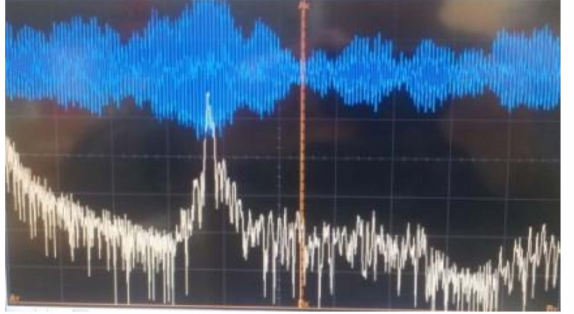
Figure 13. Signal detail after an o/e conversion and its spectrum—coherent heterodyne detection